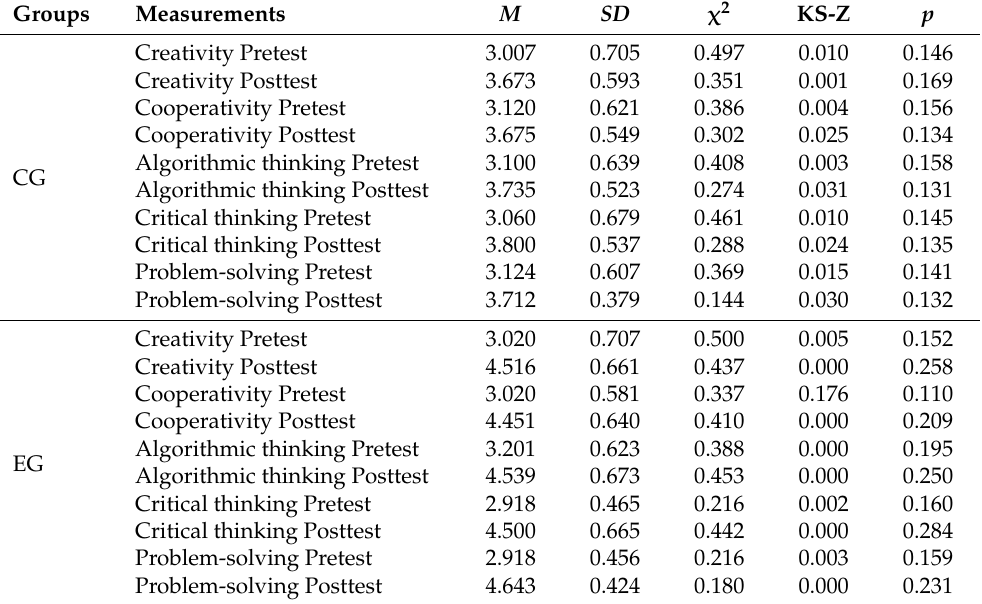
Table 3. Descriptive statistics of the experimental group (EG) and the control group (CG) and normality test results with Kolmogorov–Smirnov